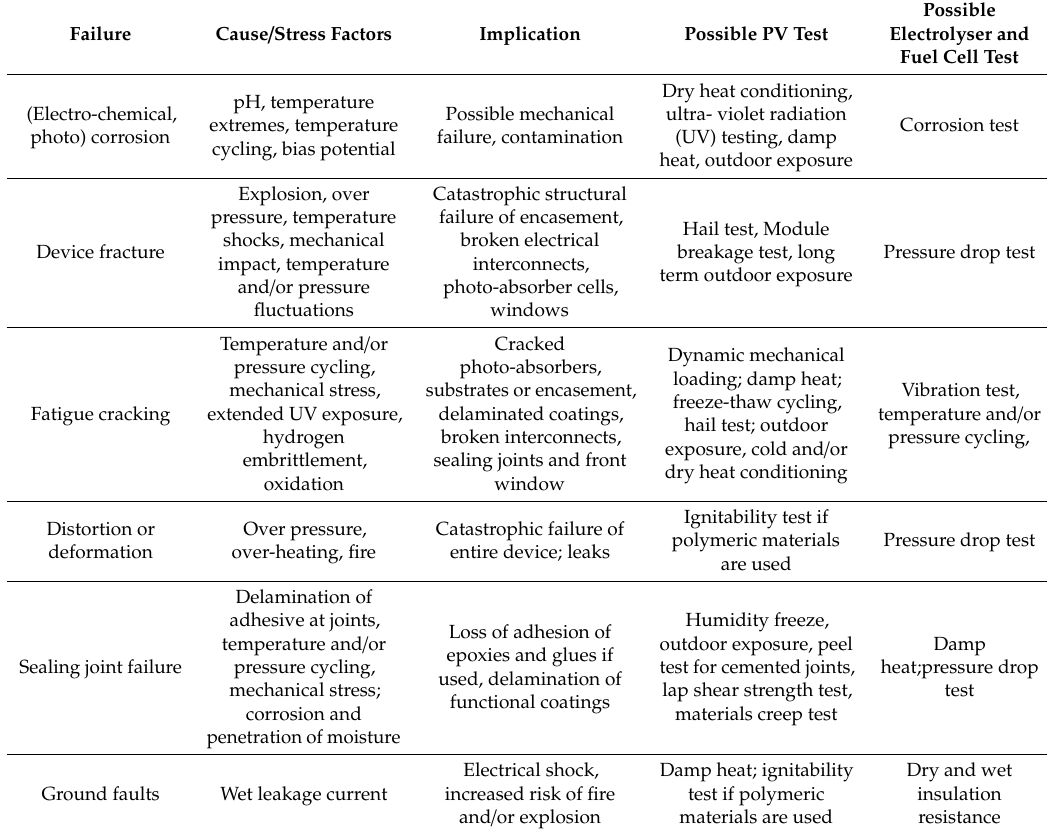
Table 3. Possible failure modes in PEC devices, their causes and possible qualification tests.